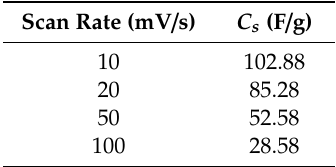
Table 4. Calculated C s of the EDLC from CV curves.